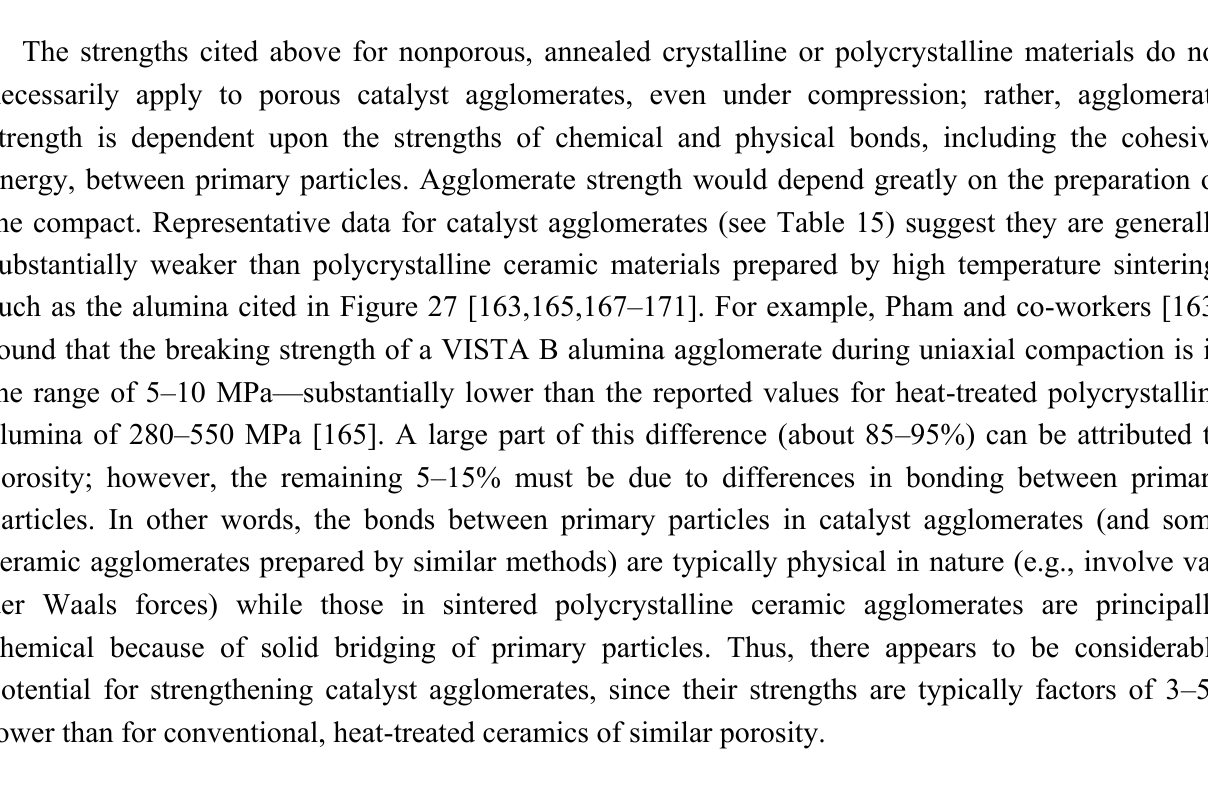
Table15. Mechanical Strengths and Attrition Rates of Catalyst Supports Compared to Those of Sintered Ceramic